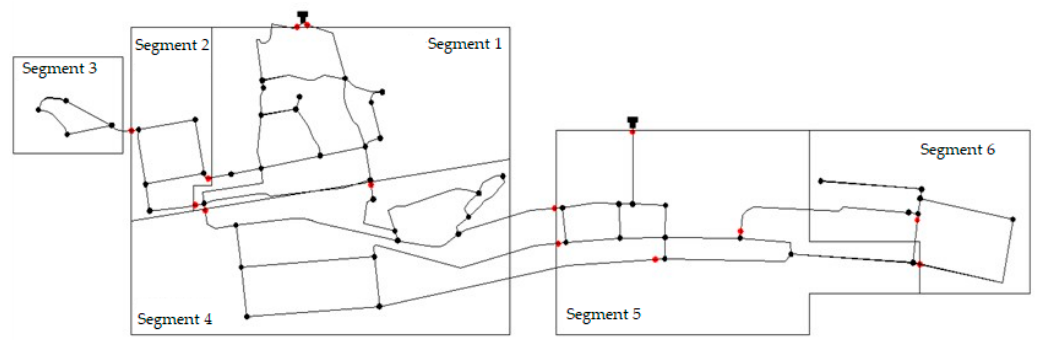
Figure 3. Scenario n°6: 14 shut-off valve and 6